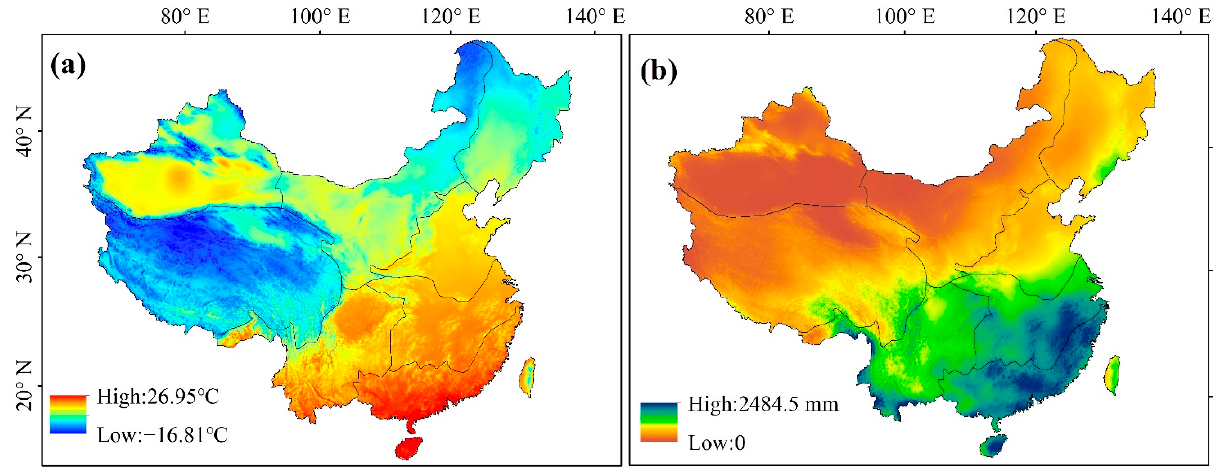
Figure 8. Spatial distribution of average annual temperature and precipitation from 1982 to 2018: ( a ) temperature; ( b )